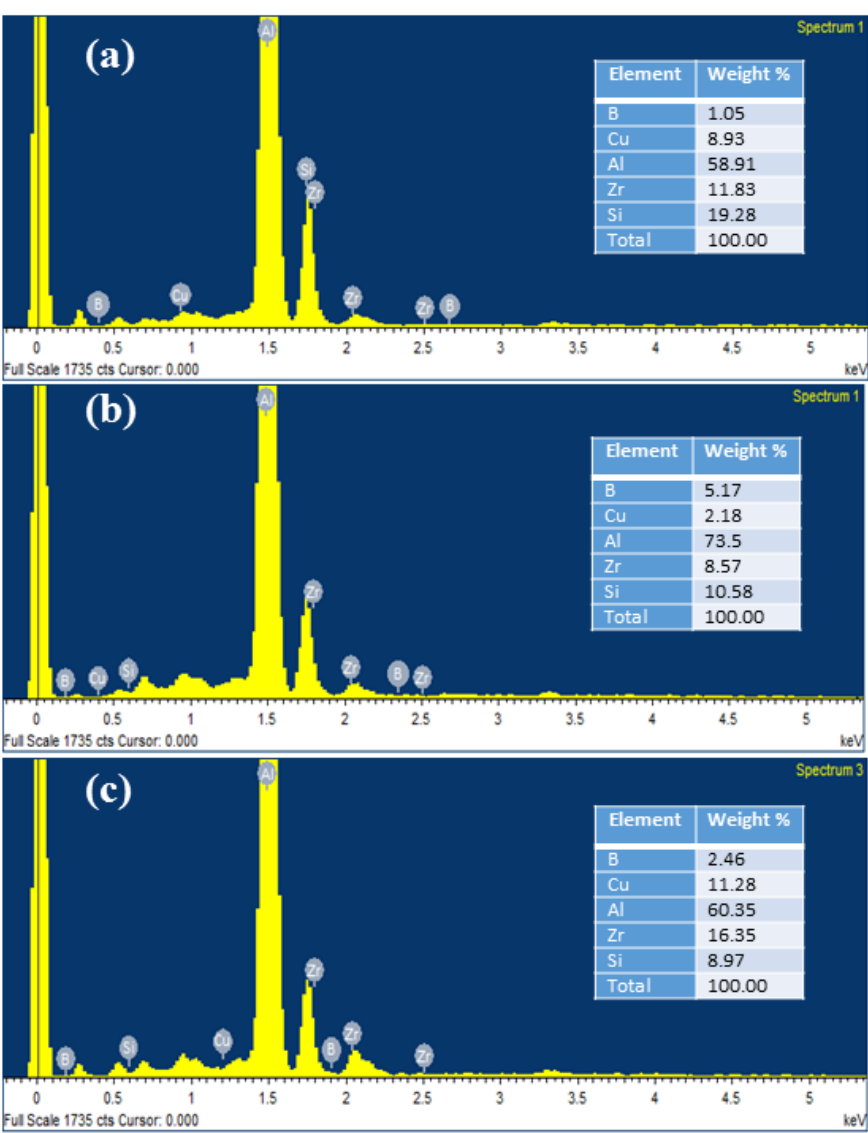
Figure 3. Energy spectrum produced by EDAX analysis for ( a ) 3 wt.% ZrB 2 composites; ( b ) 6 wt.% ZrB 2 composite; ( c ) 9 wt.% ZrB 2 composite.